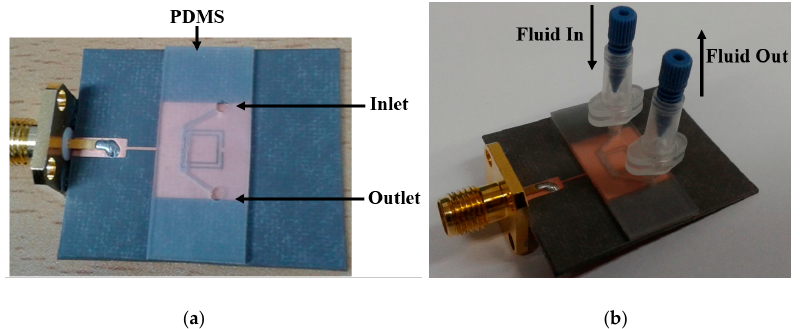
Figure 8. ( a ) Fabricated prototype of CSRR-loaded microfluidic patch as ethanol chemical sensor; ( b ) Side view with nanoport assembly.